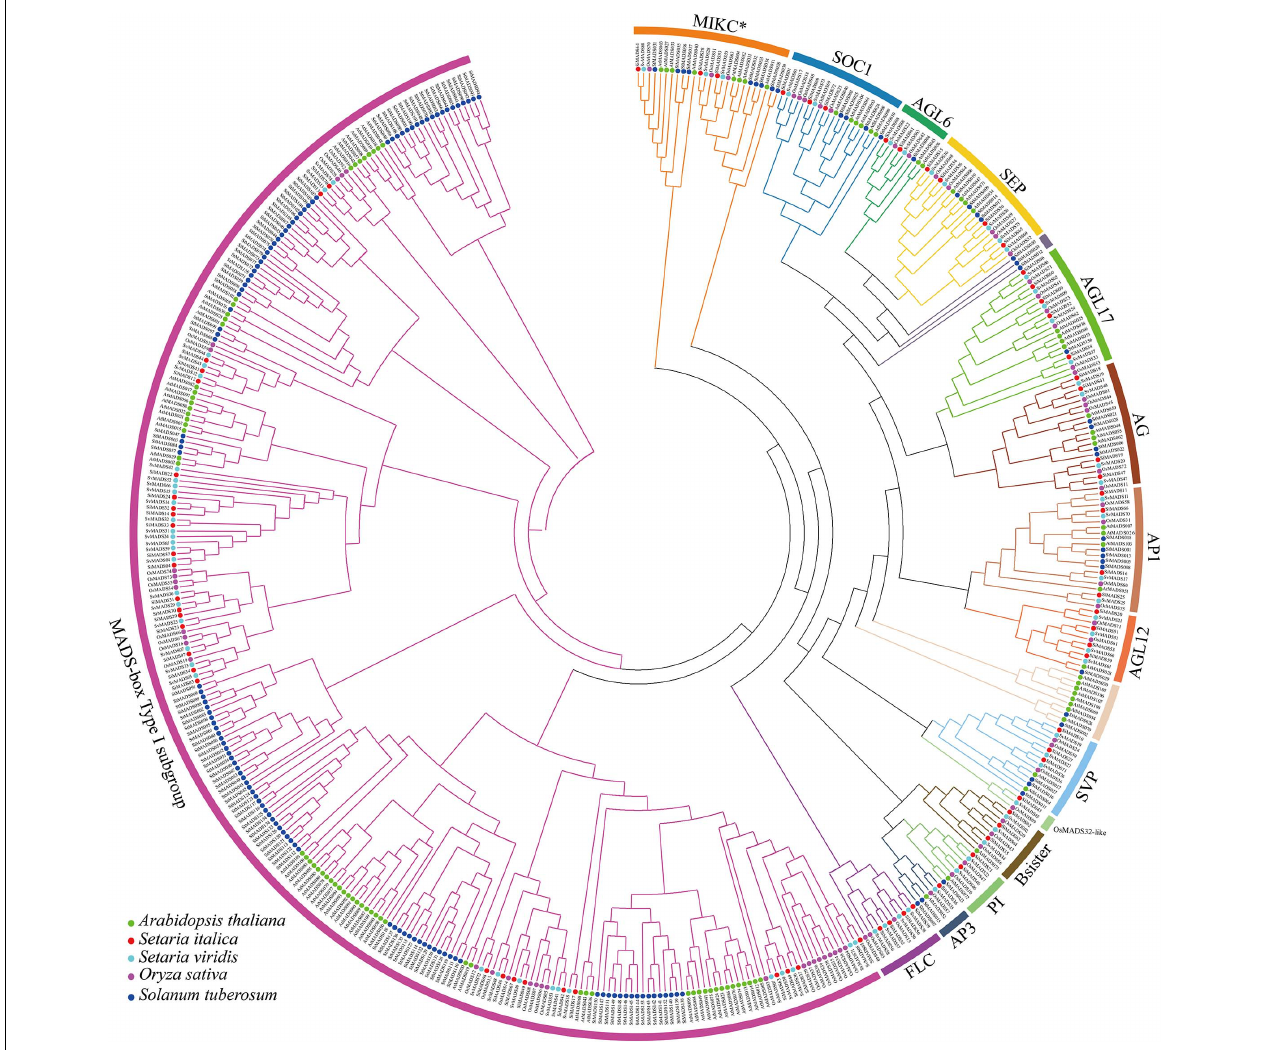
FIGURE 1 | Phylogenetic analysis of MADS-box transcription factor genes in foxtail millet, Arabidopsis , Setaria viridis , potato ( Solanum tuberosum ), and rice ( Oryza sativa L.). A total of 488 MADS-box protein sequences were used to construct the ML (maximum likelihood) tree. The different clades were marked respectively in different